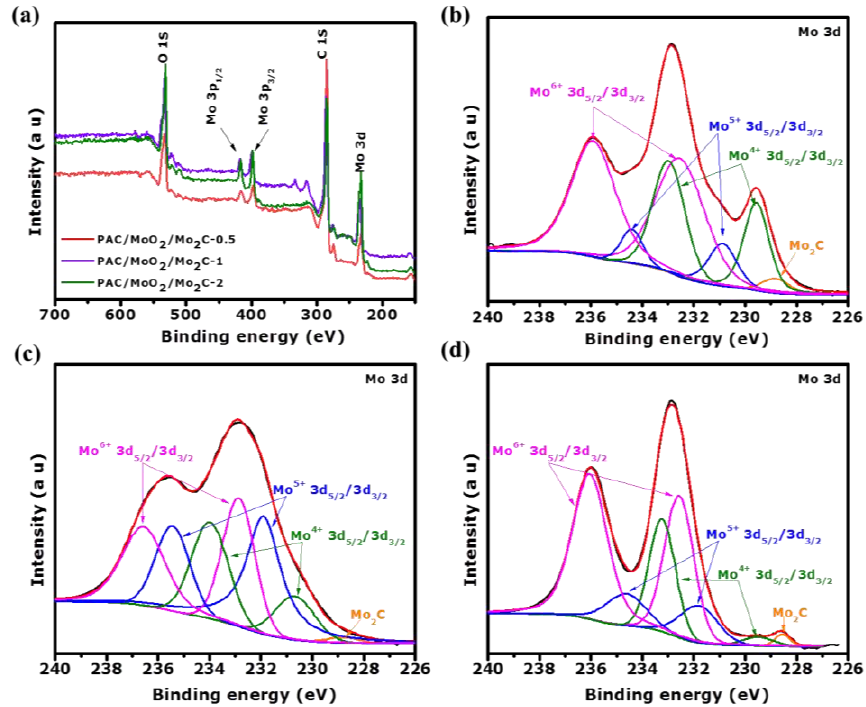
Figure 7. ( a ) XPS survey spectra of the as-synthesized ternary composites and high resolution of Mo 3d, ( b ) PAC/MoO 2 /Mo 2 C-0.5, ( c ) PAC/MoO 2 /Mo 2 C-1 and ( d ) PAC/MoO 2 /Mo 2 C-2 ternary composites. Table 3. Elemental composite of the PAC/MoO 2 /Mo 2 C ternary composites. Elemental Composition (at.%)